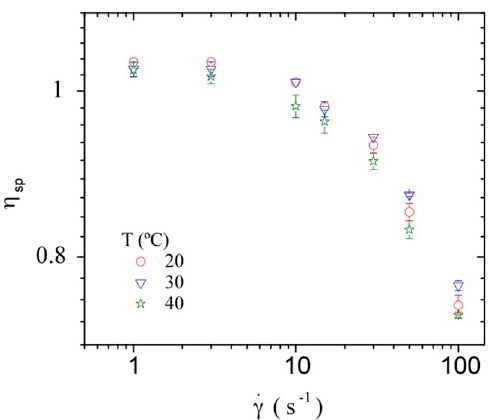
Figure 10. Dependence of the specific viscosity η sp , obtained from the shear viscosity at zero shear rate, for a DNA concentration of 0.2 mg/mL in NaCl 1 × 10 − 2 M, on shear rate at the different temperatures studied, i.e. , 20, 30 and 40 °C.